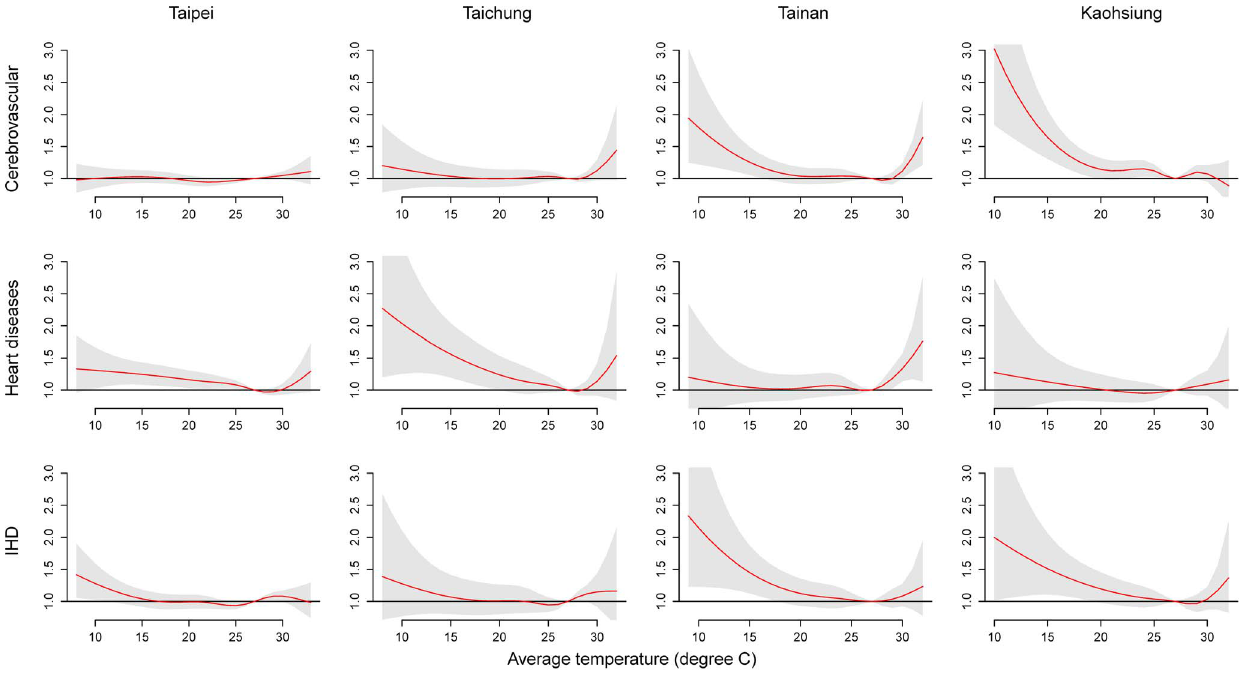
Figure 2. Associations between mortality from cerebrovascular diseases, heart diseases, and ischemic heart disease and daily average temperatures in metropolitans Taipei, Taichung, Tainan, and Kaohsiung during 1994–2007. Cumulative 4-day (lag 0 to 3) RRs were estimated using DLNM with a centered temperature of 27 u C.